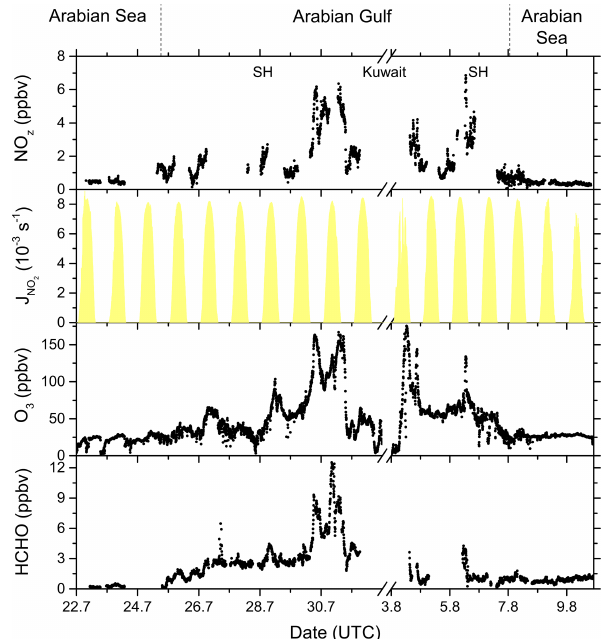
Figure 15. NO z , O 3 , and HCHO mixing ratios, together with NO 2 photolysis rates, during the transitions between the Arabian Sea and Arabian Gulf, as well as in the Arabian